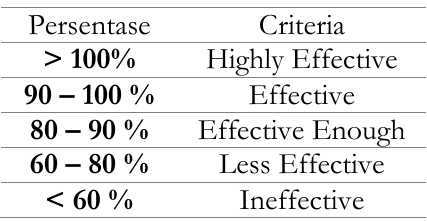
Effectiveness Assessment